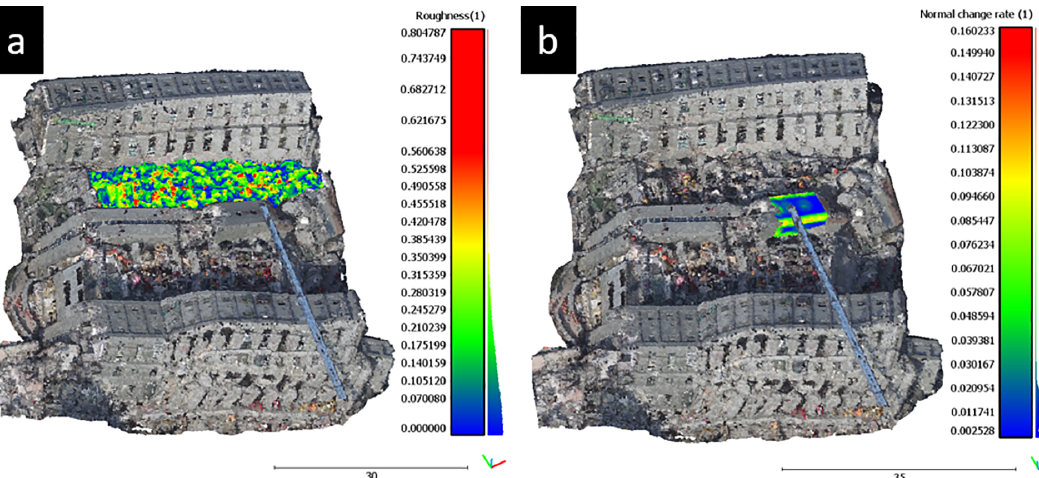
Figure 3. Segments selected for the depictability of damage-related feature analysis. (a) Damage segment (roughness values), (b) non- damage segment (normal change rate values).